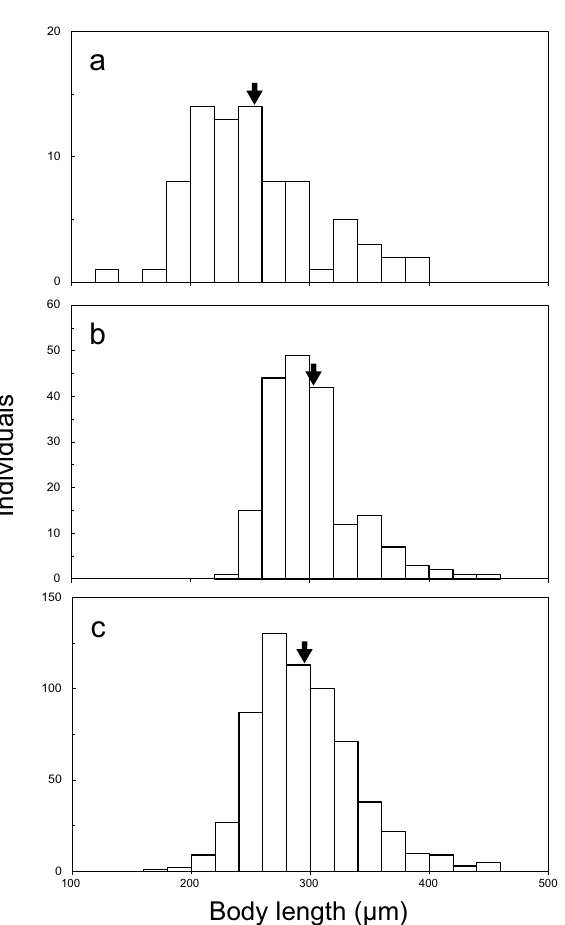
Figure 5. Body size (expressed here as body length) of tardigrades living in green snow (20 µm size increments). ( a ) Collected in April, 2018, ( b ) collected in May, 2018, ( c ) collected in May, 2019. Mean values are shown by the